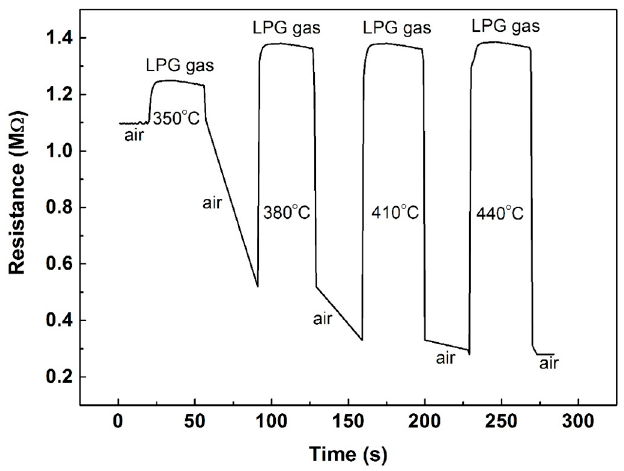
Figure 5. The response and recovery behavior of TTO2 to 10,000 ppm liquefied petroleum gas (LPG) at different temperatures.